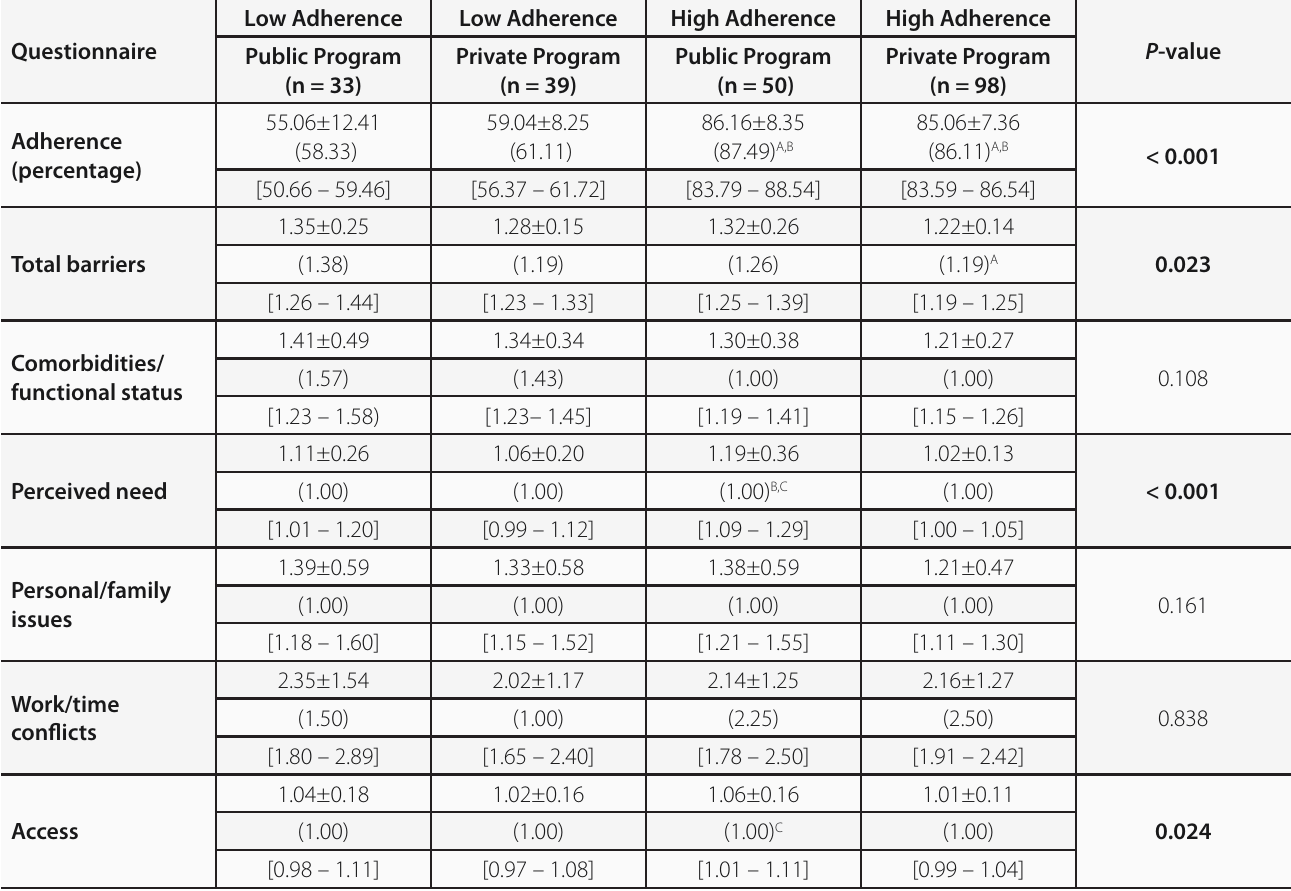
Table 3. Adherence and barriers to cardiac rehabilitation according to the type of program and